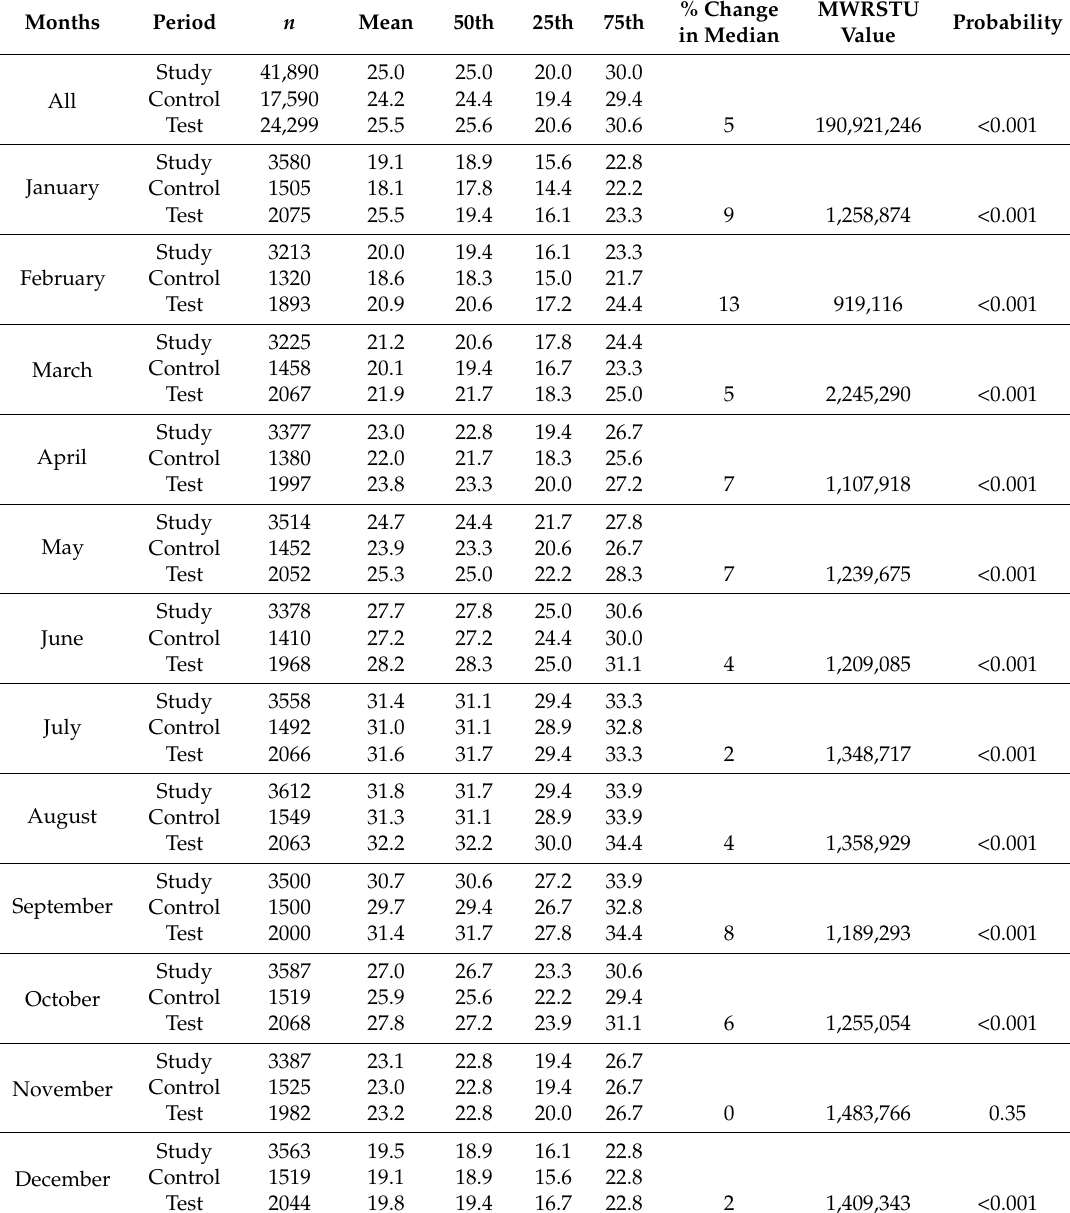
Table 2. Air temperatures in Pasadena between 1886–2016All results are in Degrees CentigradeDaily maximum